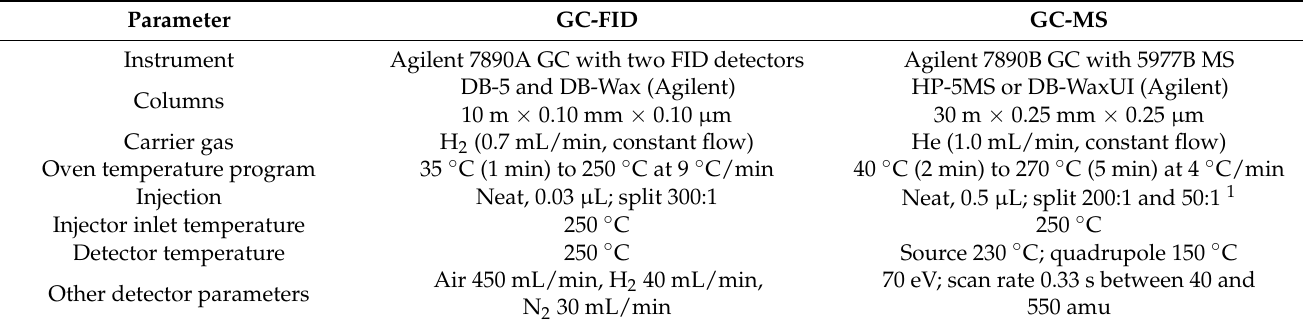
Table 3. Gas chromatographic (GC) instrumental parameters used in this